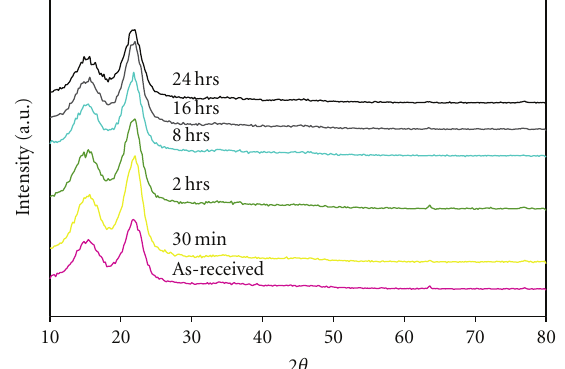
Figure 12: E ff ect of alkali treatment on crystallinity of as-received and alkali-treated kenaf.